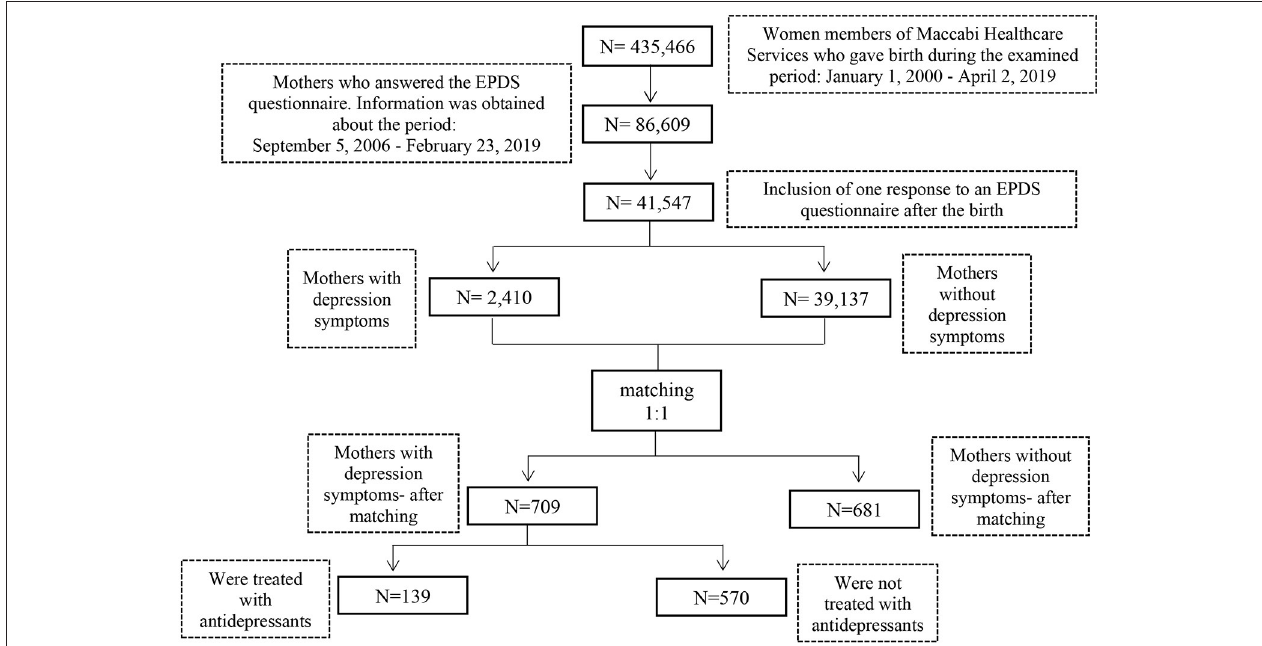
FIGURE 1 | Flow chart depicting the inclusion process of the study cohort.